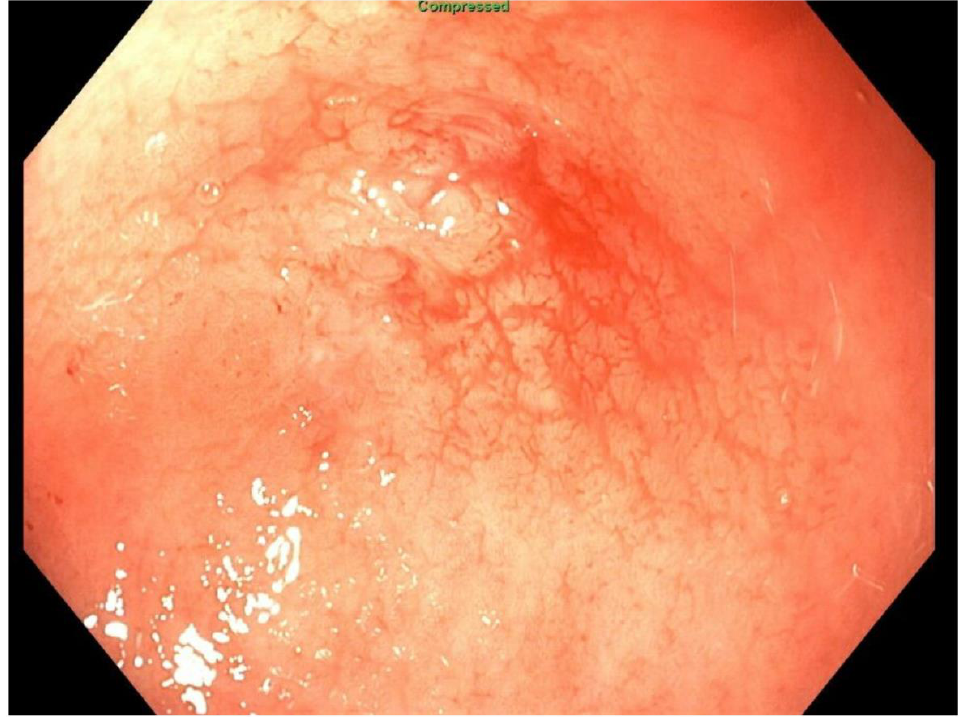
Figure 7. Endoscopic view of blind proximal end of gastric remnant.